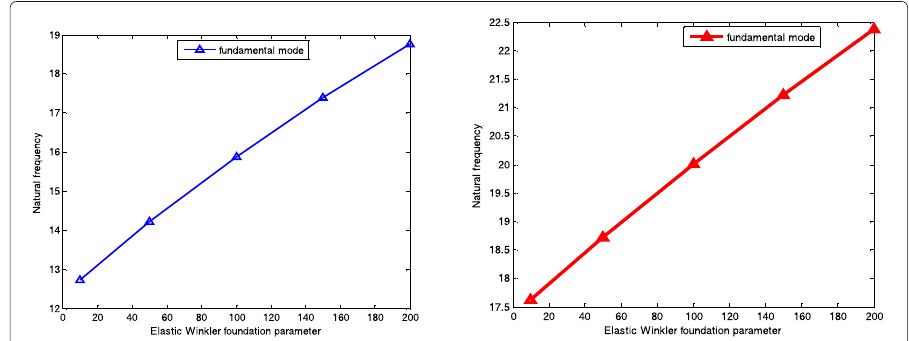
Fig. 7 Variation of foundation parameter on SS-edge and SC edge